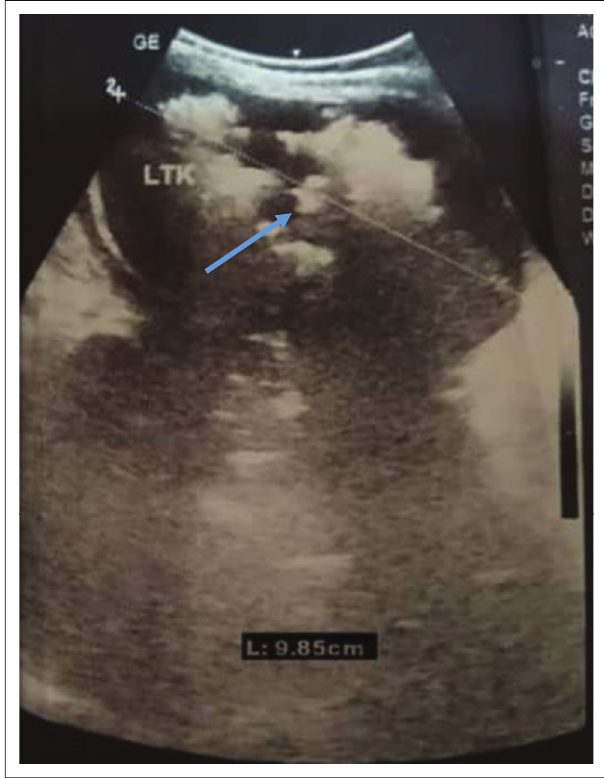
(Table 1). Human immunodeficiency virus DNA polymerase